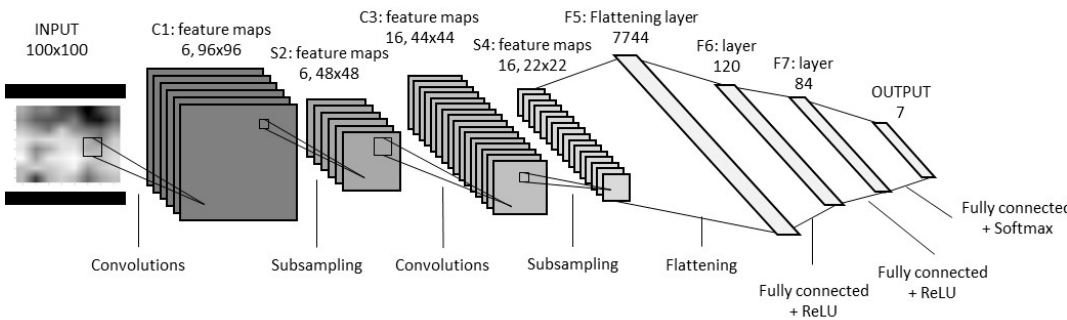
Figure 8. Structure of the CNN model for data analysis.